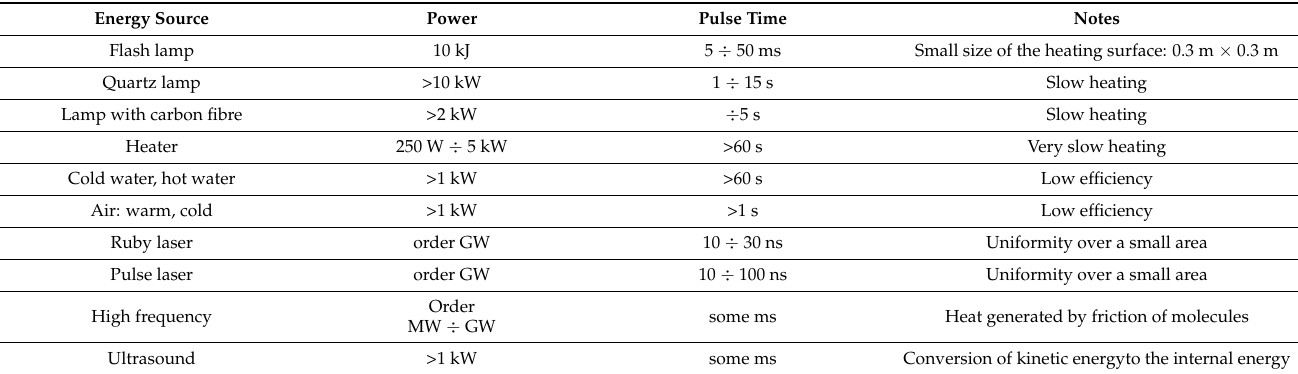
Table 3. Overview of thermal energy sources used in pulsed